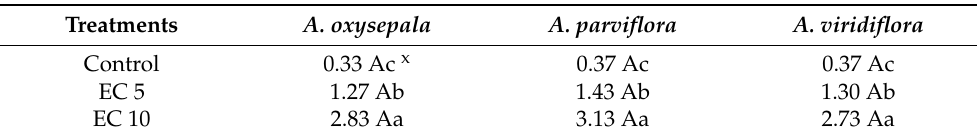
Table 4. Electrical conductivity of growing medium (soil:water = 1:5) of A. oxysepala , A. parviflora , and A. viridiflora irrigated with tap water (control) or salt solution at an electrical conductivity (EC) of 5 dS · m − 1 (EC 5) and 10 dS · m − 1 (EC 10).